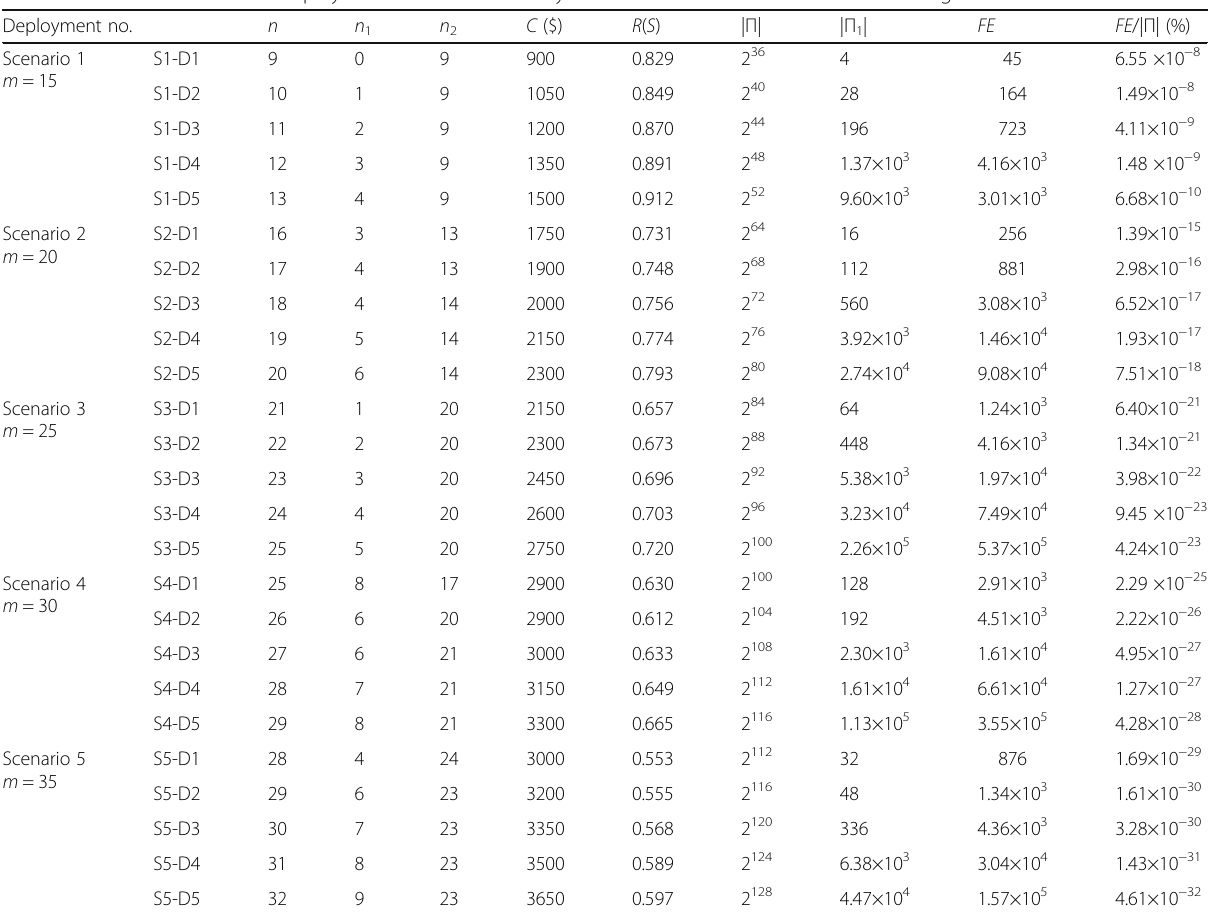
Table 4 Data of the obtained deployments for the case-study surveillance WSN for the RoI shown in Fig. 5 Deployment